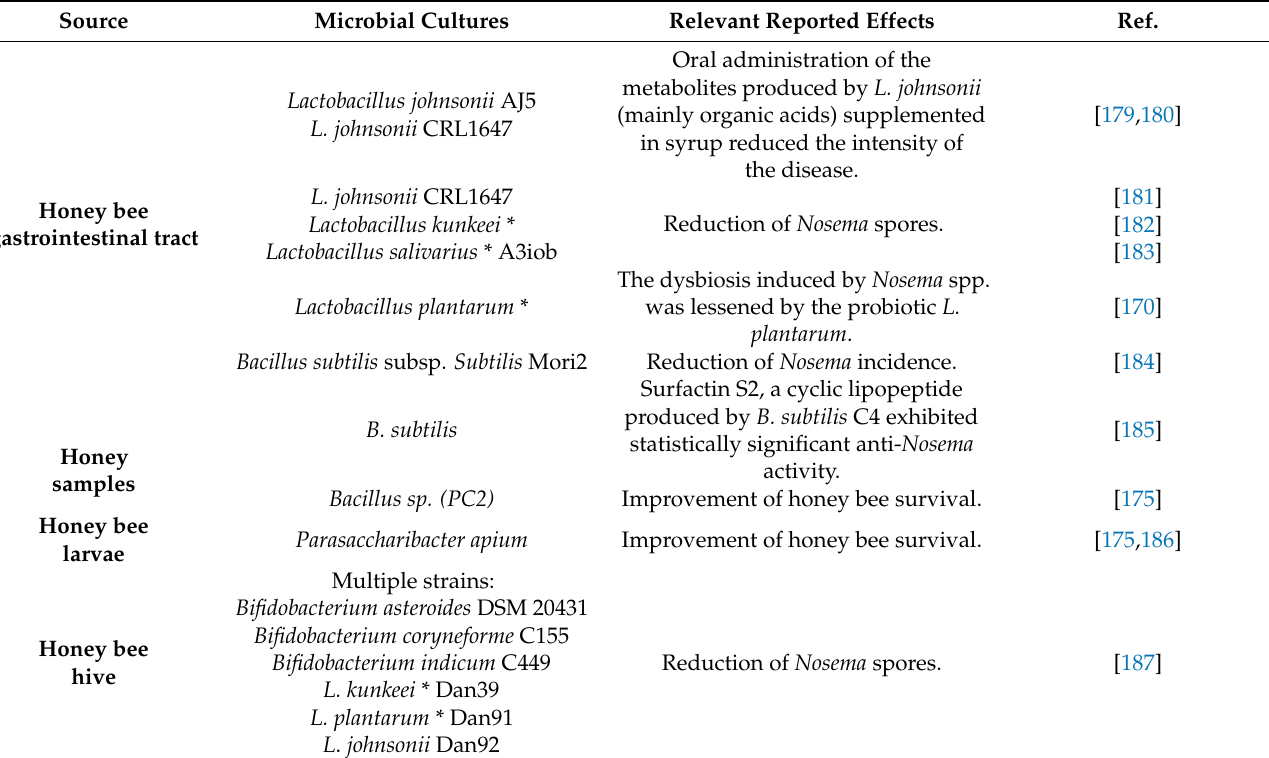
Table 2. Overview of the main effects obtained in the biocontrol of Nosema using different microbial